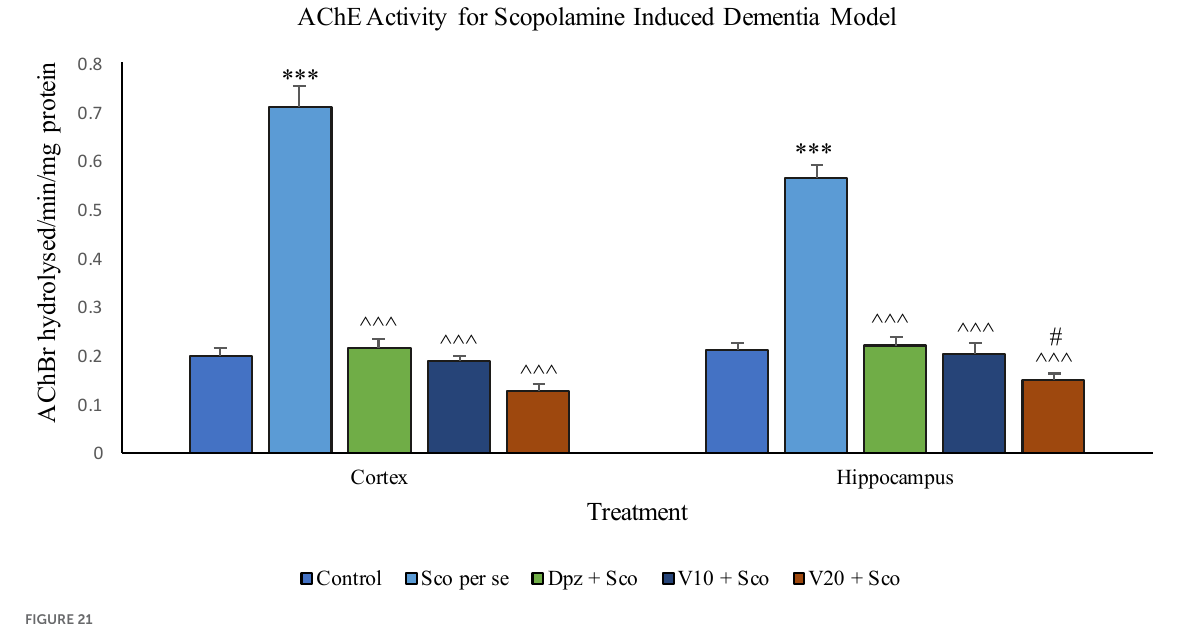
FIGURE21 Effect of vanillin and other treatments on AChE activity. Data are expressed as mean ± SEM. “***” denotes P < 0.001 with respect to the control group. “#” denotes P < 0.05 with respect to the standard treatment group. “ ∧∧∧ ” denotes P < 0.001 with respect to the negative control (Sco per se )